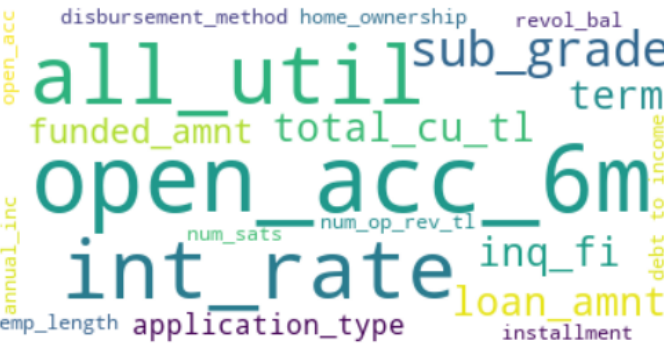
Figure 2. Wordcloud of the selected